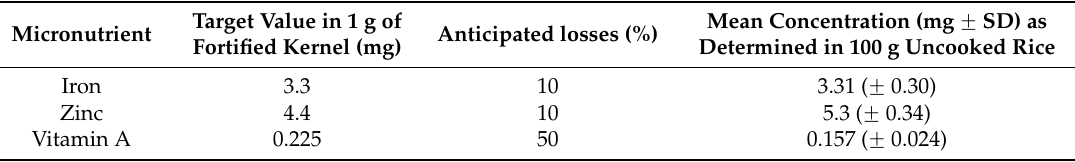
Table 1. Target levels for fortified rice as kernel and for 100 g of uncooked